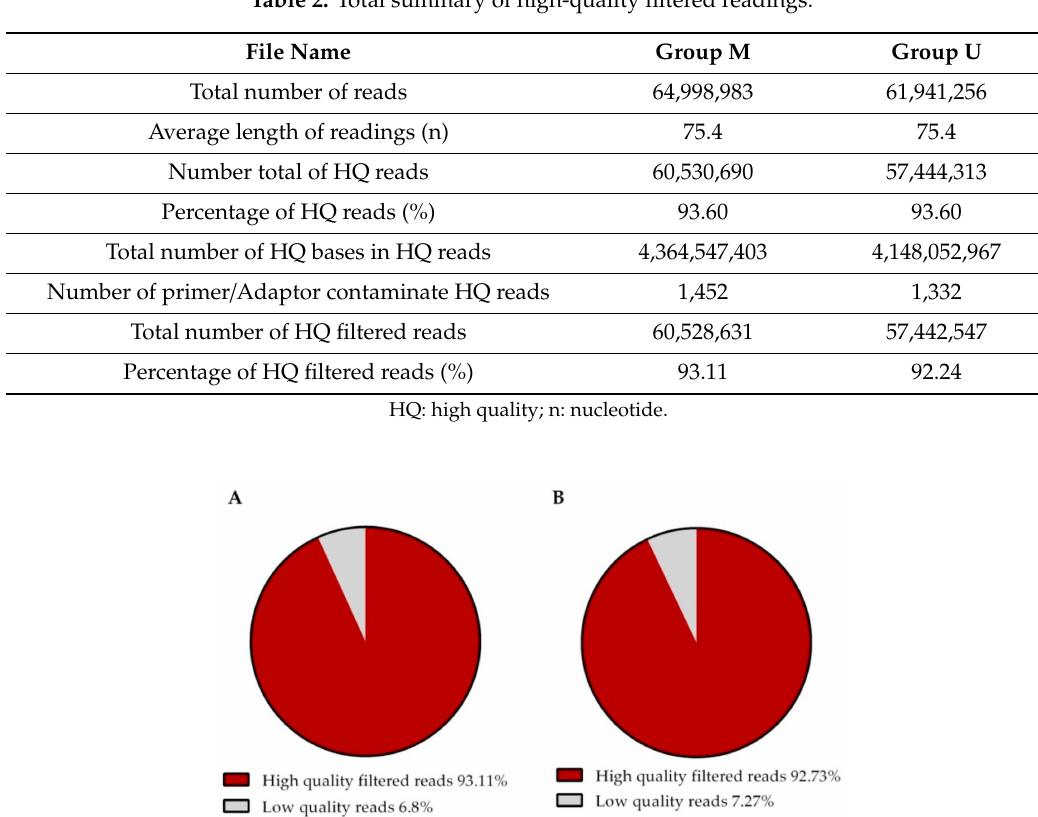
Table 2. Total summary of high-quality filtered readings.